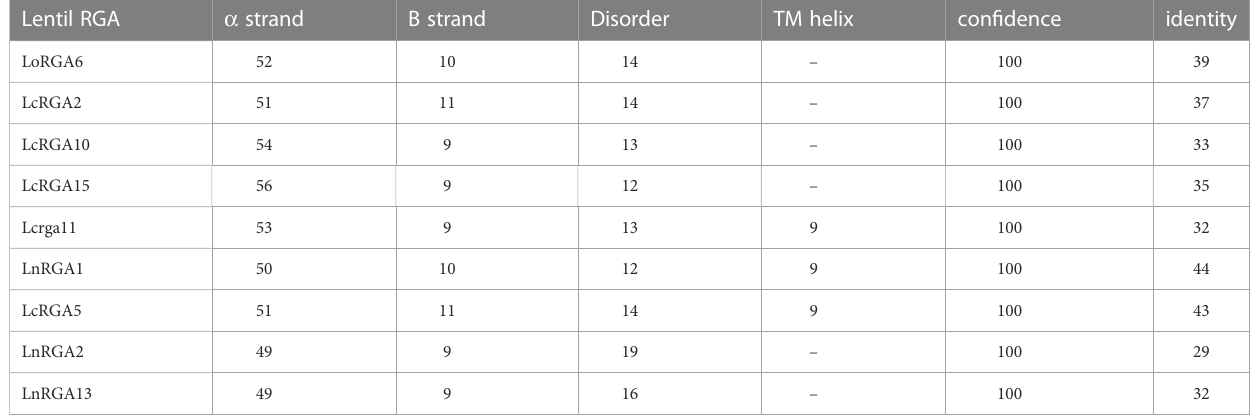
TABLE 5 Secondary structure composition of representative lentil RGAs using Phyre 2 software.